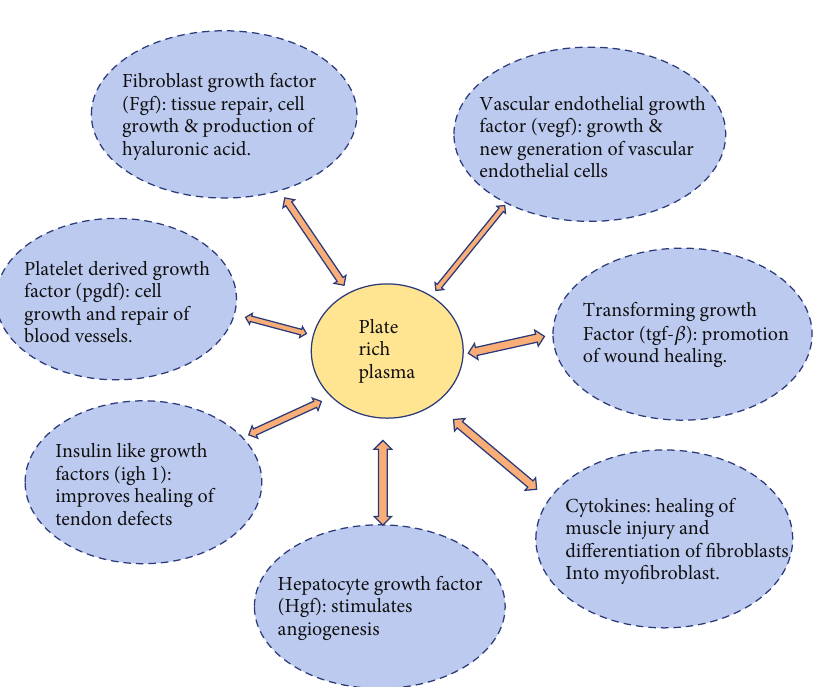
Figure 3: Evaluation of PRP preparations.